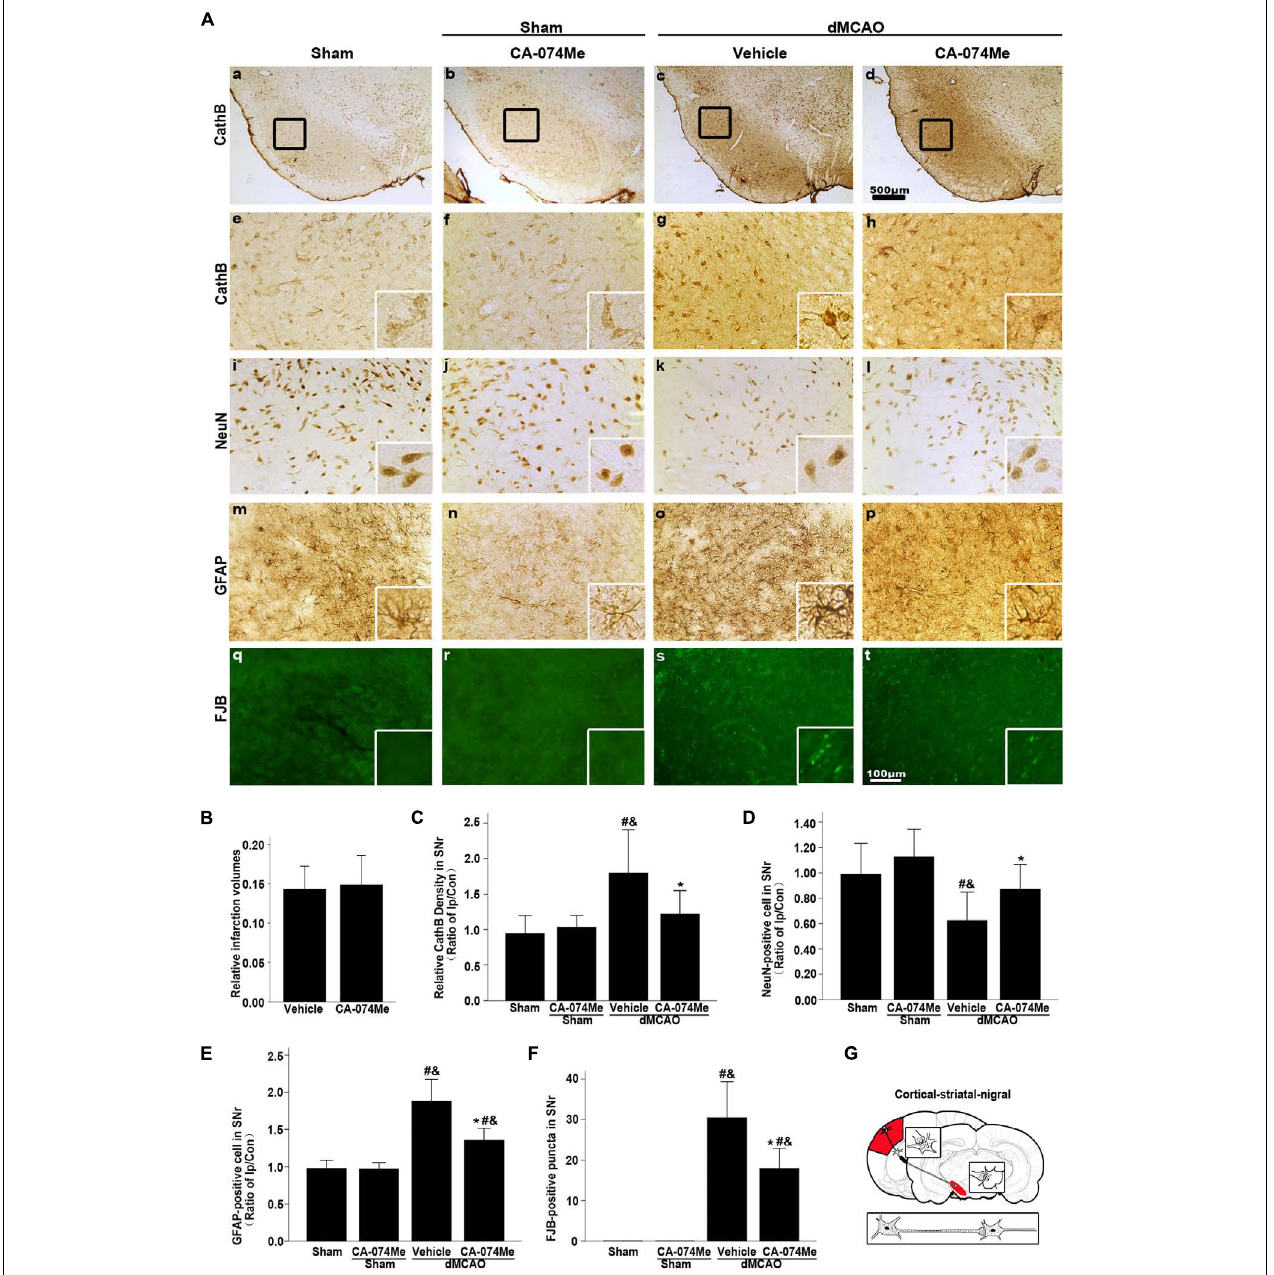
FIGURE 8 | Delayed CA-074Me treatment alleviated secondary degeneration of ipsilateral SNr after dMCAO. (A) Representative microphotographs of immunostaining of CathB, NeuN, GFAP, and FJB staining in the ipsilateral SNr. Scale bar: e–t : 100 µ m; a–d : 500 µ m; a , e , i , m , q , the ipsilateral SNr in sham-operated group; b , f , j , n , r , the ipsilateral SNr in sham-operated group with CA-074Me; c , g , k , o , s , the ipsilateral SNr in the vehicle group after dMCAO; d , h , l , p , t , the ipsilateral SNr in the CA-074Me group after dMCAO. (B) Relative infarction volumes in the vehicle ( n = 6) and CA-074Me ( n = 6) groups after dMCAO. (C) Quantitative analysis of CathB-positive density in the SNr at sham-operated group ( n = 5), sham-operated with CA-074Me group ( n = 5), vehicle ( n = 6), and CA-074Me ( n = 8) groups after dMCAO. (D) Quantitative analyses of NeuN-positive cells in the ipsilateral SNr at sham-operated group ( n = 5), sham-operated with CA-074Me group ( n = 5), vehicle ( n = 6), and CA-074Me ( n = 8) groups after dMCAO. (E) Quantitative analyses of GFAP-positive cells in the ipsilateral SNr at sham-operated group ( n = 5), sham-operated with CA-074Me group ( n = 5), vehicle ( n = 6), and CA-074Me ( n = 7) groups after dMCAO. (F) Quantitative analyses of FJB-positive substance in the ipsilateral SNr at sham-operated group ( n = 5), sham-operated with CA-074Me group ( n = 5), vehicle ( n = 7), and CA-074Me ( n = 6) groups after dMCAO. Data was expressed as the ratio of ipsilateral/contralateral. Each bar represents the mean ± SD. ∗ p < 0.05 versus the vehicle group. # p < 0.05 versus the sham-operated group; & p < 0.05 versus the sham-operated with CA-074Me group. (G) Schematic illustration of cortico-striatum-nigral pathway in rats after dMCAO. NeuN, neuron-specific nuclear-binding protein; GFAP, glial fibrillary acidic protein; FJB, Fluoro-Jade B; Ip, ipsilateral; Con, contralateral; Cor, cotrex; Str, striatum; SNr, substantia nigra pars reticulata; Sham;